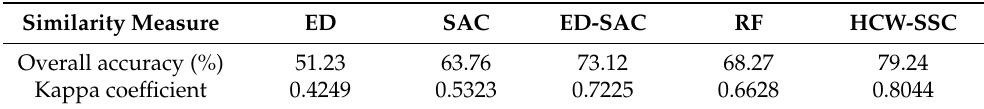
Table 5. Overall accuracy and kappa coefficient of each similarity measure based on AVIRIS HSI (Euclidean distance (ED), spectral angle cosine (SAC), Euclidean distance–spectral angle cosine (ED-SAC), random forest (RF), and a new hybrid changing-weight classification method with a filter feature selection (HCW-SSC)).